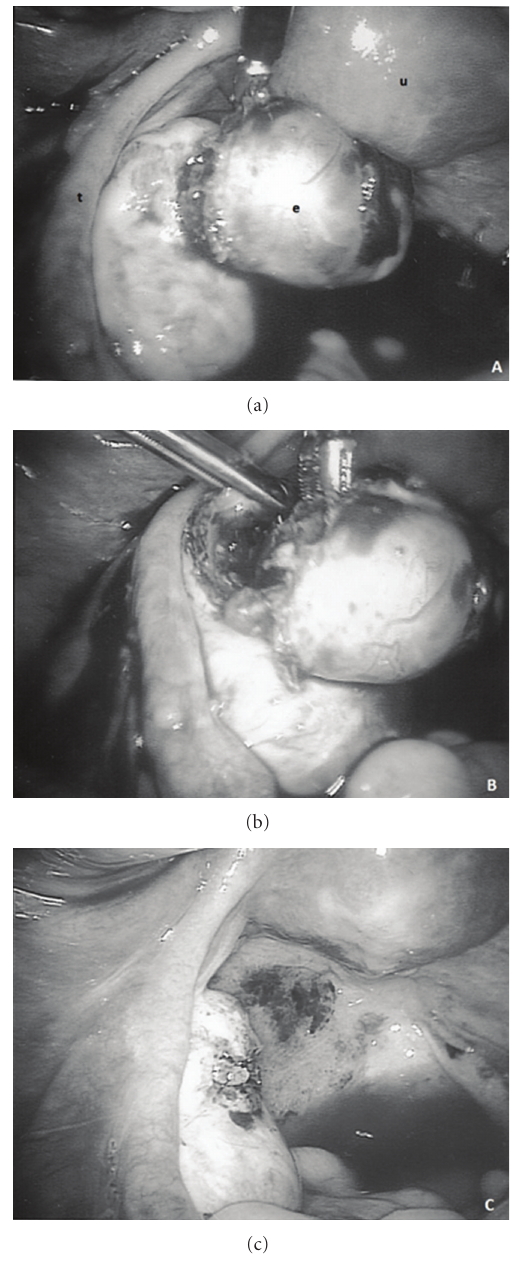
Figure 2: The laparoscopic treatment of the ovarian pregnancy: (a) at the beginning of the procedure: normal aspect of the uterus (u) and left fallopian tube (t), ruptured ectopic pregnancy in the left ovary (e); (b) gestational sac shelled out of the encasing ovarian tissue; (c) appearance of the left ovary after removal of ectopic